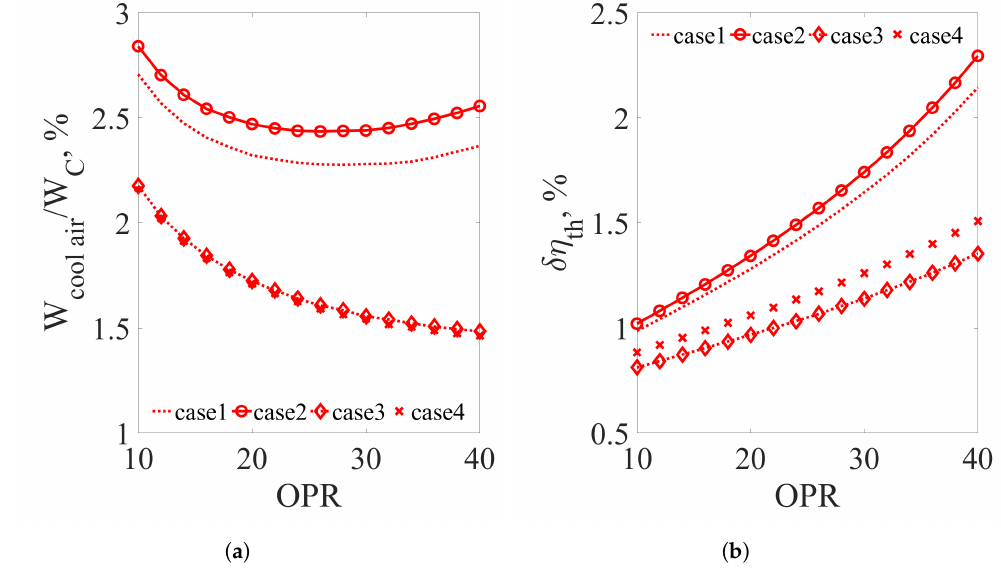
Figure 13. Cooling air compressor work and its effect on cycle efficiency as a function of the cycle pressure ratio for the four versions of the Humphrey cycle presented in Table 3. TIT: 1700 ◦ C. ( a )